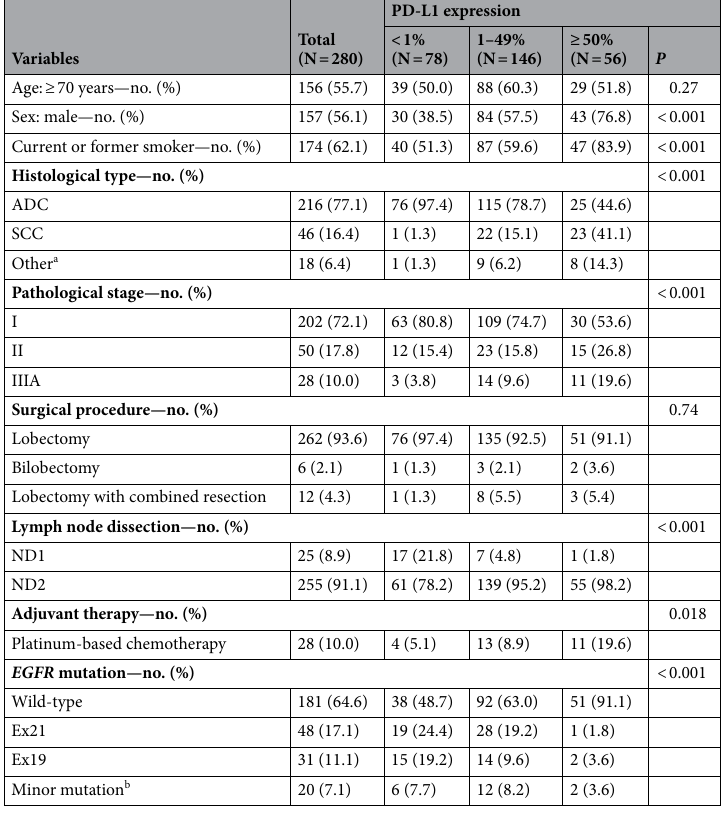
Table 1. Association between the PD-L1 expression and patient clinicopathological variables. PD-L1 programmed cell death-ligand 1, ADC adenocarcinoma, SCC squamous cell carcinoma, EGFR epidermal histological types of NSCLC with the exclusion of ADC and SCC. Of 18 cases, 2 patients with large cell carcinoma, 3 patients with adenosquamous carcinoma, 7 patients with large cell neuroendocrine